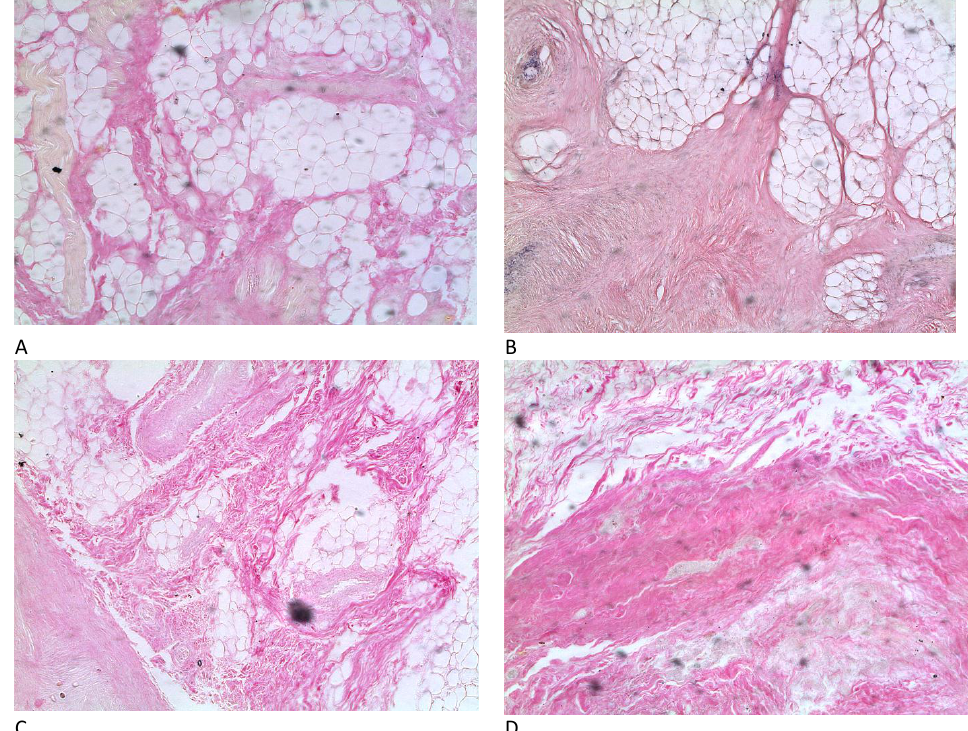
Figure 3. Microstructure samples of combs hydrolysates (hematoxylin-eosin dying) A1,A2 – control sample in the start time; B1, B2 – Hydrolyzed control sample; C1, C2 – Hydrolyzed test sample with BLC; D1, D2 – Hydrolyzed test sample with Propionix LCSC